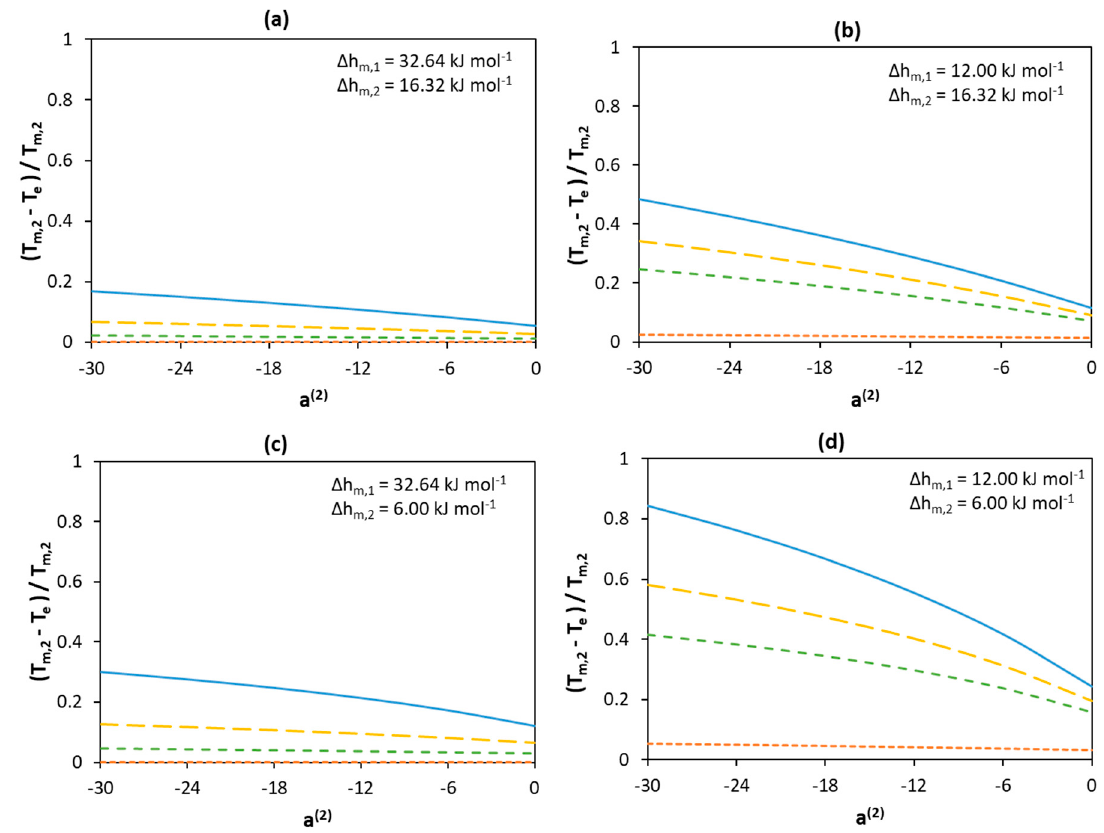
Figure 5. Effect of non-ideality of components on the normalized depression at eutectic temperature relative to the melting temperature of Component 2 assuming different melting enthalpy values of components ( a ) ∆h (cid:2923),(cid:2869) = 32.64 kJ mol (cid:2879)(cid:2869) and ∆h (cid:2923),(cid:2870) = 16.32 kJ mol (cid:2879)(cid:2869) ( b ) ∆h (cid:2923),(cid:2869) = 12.00 kJ mol (cid:2879)(cid:2869) and ∆h (cid:2923),(cid:2870) = 16.32 kJ mol (cid:2879)(cid:2869) ( c ) ∆h (cid:2923),(cid:2869) = 32.64 kJ mol (cid:2879)(cid:2869) and ∆h (cid:2923),(cid:2870) = 6.00 kJ mol (cid:2879)(cid:2869) ( d ) ∆h (cid:2923),(cid:2869) = 12.00 kJ mol (cid:2879)(cid:2869) and ∆h (cid:2923),(cid:2870) = 6.00 kJ mol (cid:2879)(cid:2869) . The melting temperatures of Components 1 and 2 are set to 600 K and 300 K, respectively. The parameter value is only a measure for non-ideality with no physical significance. Legend: a (1) = − 18; a (1) = − 12;